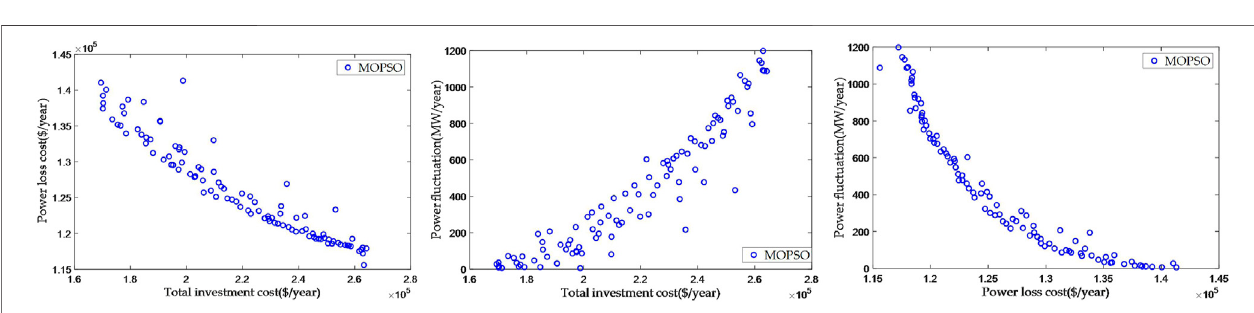
FIGURE 6 | Three-objective Pareto front results obtained by MOPSO.